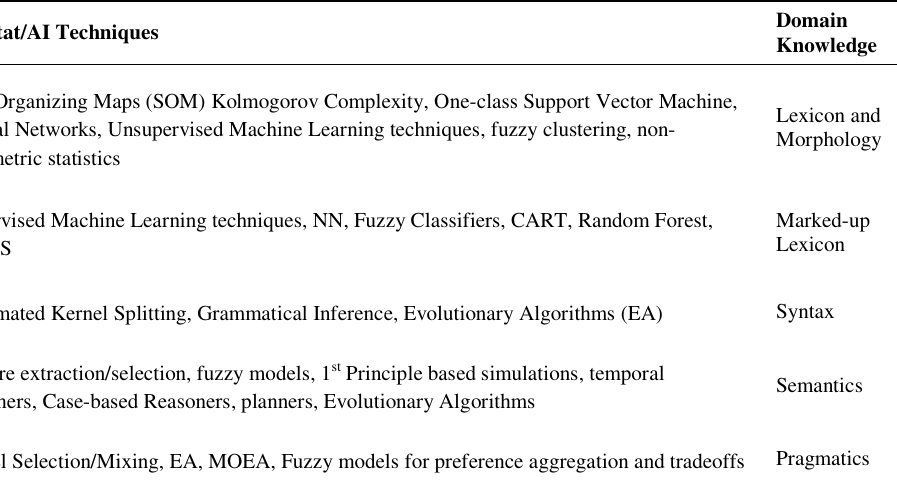
Table 1. SC Techniques & Domain